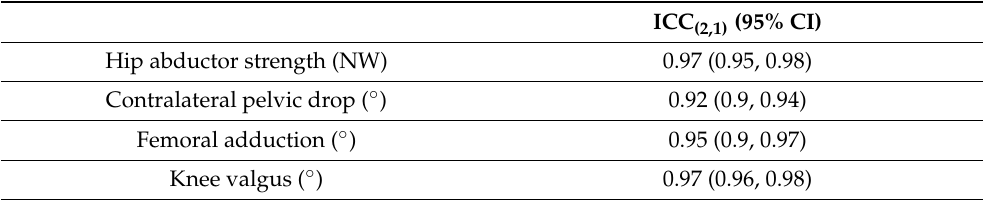
Table 1. Test-retest reliability of the study variables.